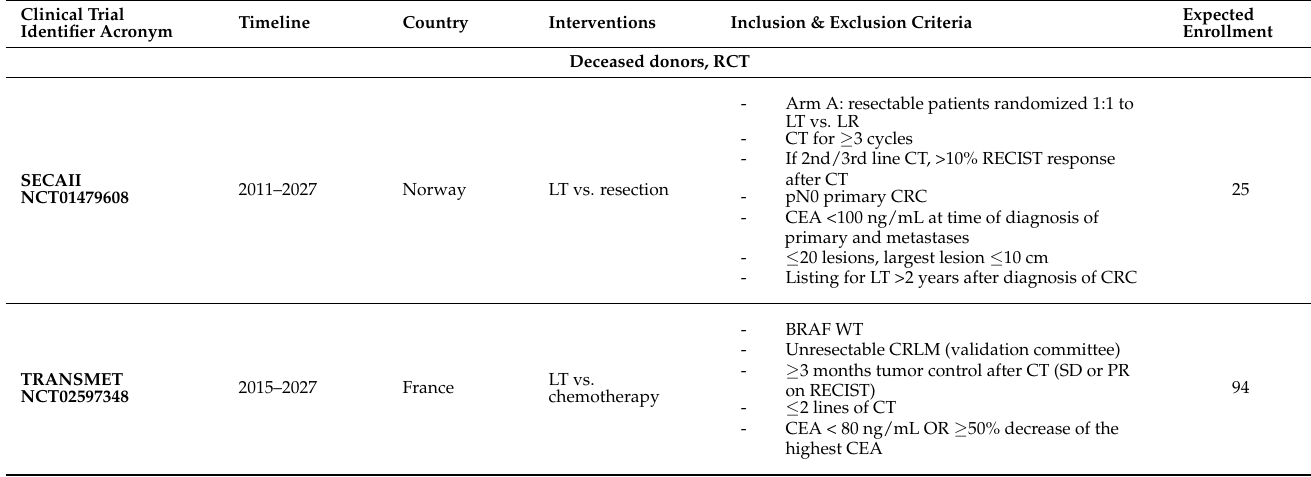
Table 1. Currently active clinical trials on liver transplantation for colorectal liver